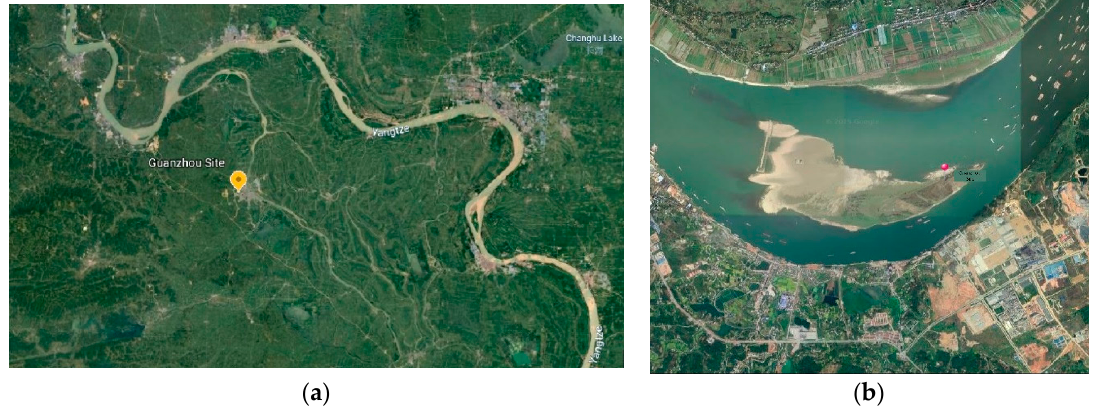
Figure 2. The location of Guanzhou site. ( a ), 1:8,000,000; ( b )